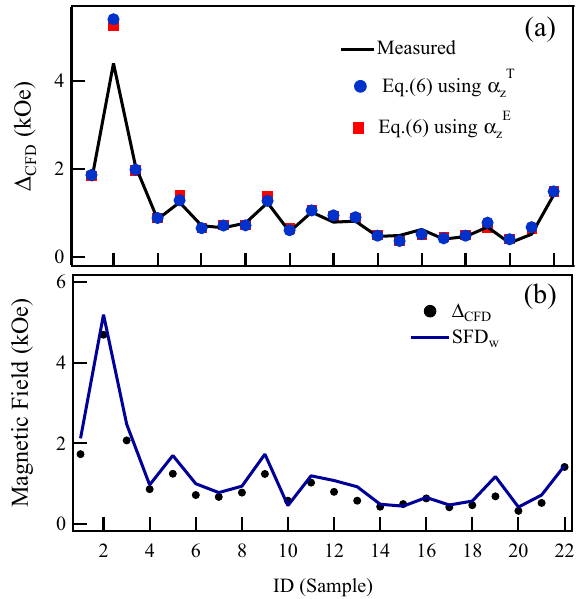
Figure 4. ( a ) Coercive field distribution width, (cid:31) CFD , measured from the FORC diagrams (continuous line) compared with the width calculated with Eq. (6) using the theoretical (circles) and experimental values (squares) of α z , and ( b ) Comparison between the full width of the FORC-CFD, (cid:31) CFD and the full width of the SFD, SFD W obtained by derivation of the major DCD remanence